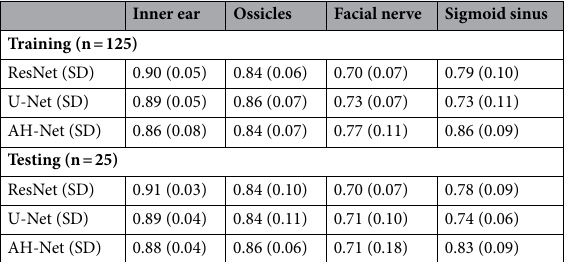
Table 2. Mean Dice similarity coefficients from the training (cross-validation) and testing using different CNN architectures. SD: Standard deviation.